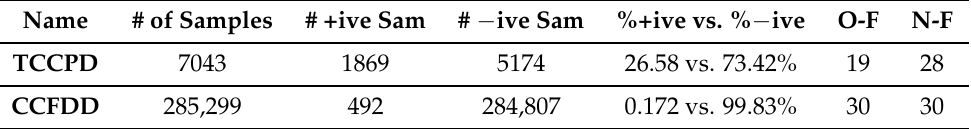
Table 1. Details of the two datasets. Sample, positive, negative, original features, and new features are represented by Sam, +ive, − ive, O-F, and N-F,